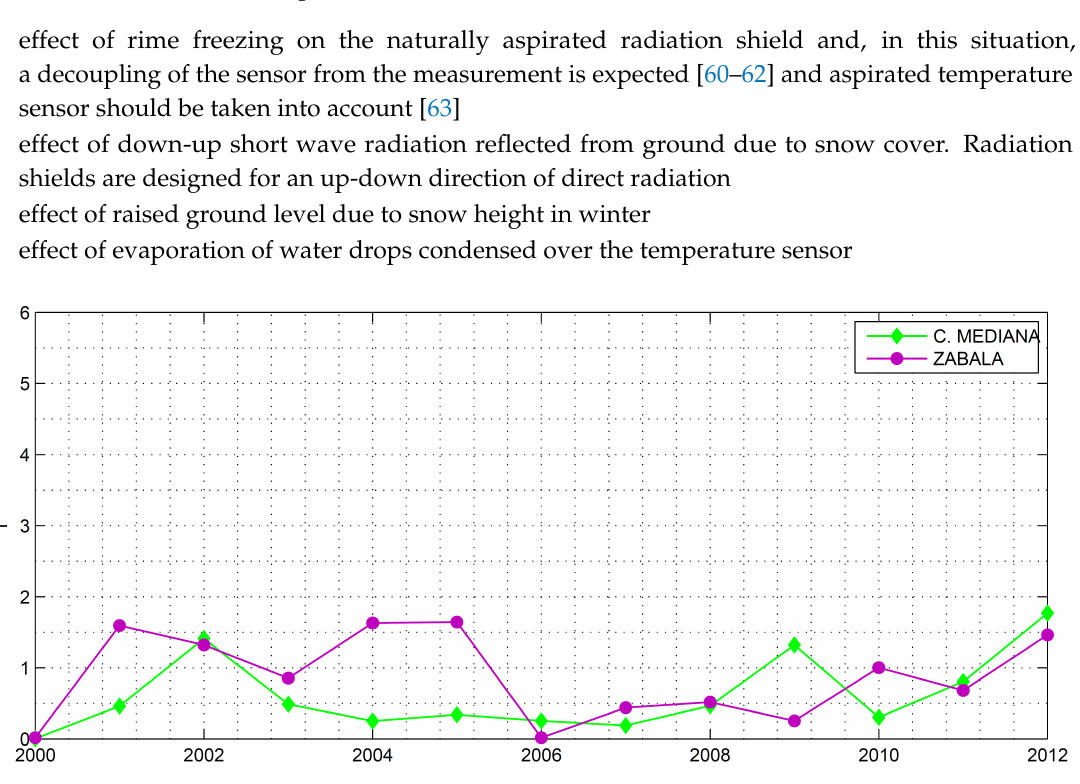
Figure 4. Values of T of an Alexandersson test for annual mean temperature observed at Cabeza Mediana and Zabala using Puerto de Navacerrada AEMET (Agencia Estatal de MEteorología) observatory as a reference station. The critical T value for 5% confidence level and 14 samples is